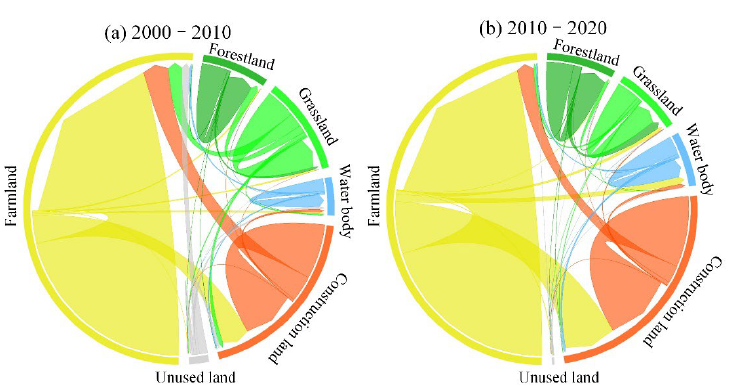
Figure 7. Transfer map of LULC types in the study area, ( a ) transfer map of LULC types from 2000 to 2010, ( b ) transfer map of LULC types from 2010 to 2020.